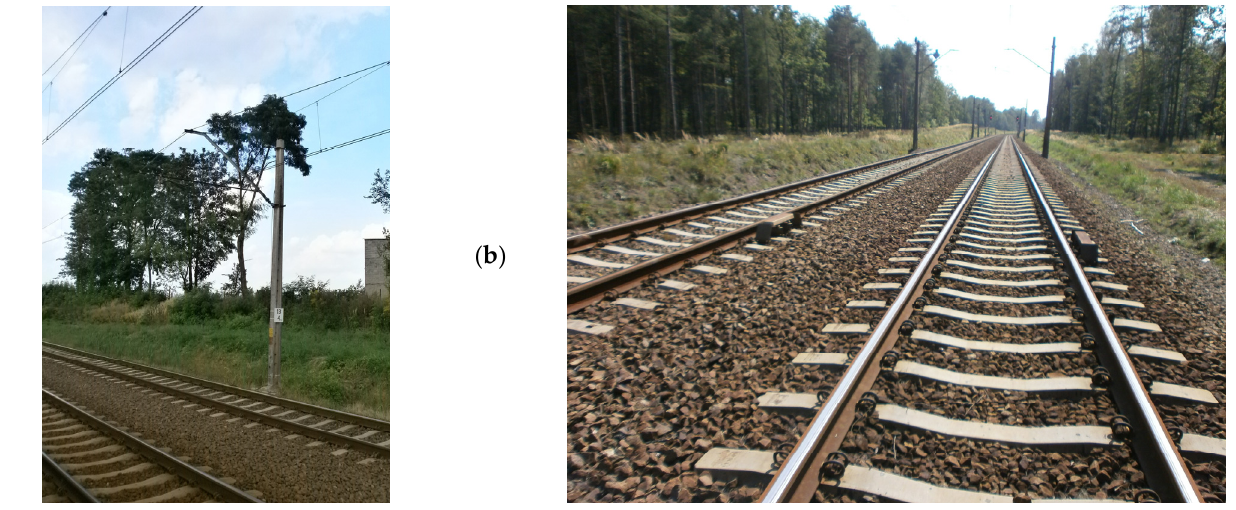
Figure 2. Railway infrastructure between ( a ) points 1 Lubliniec and 2 Rusinowice, and ( b ) points 3 Kosz ę cin and 4 Kalety. 3 Kosz˛ecin and 4 Kalety. Table 1. Technical exploitation specifications of the complete route. Technical Exploitation Parameters of Railway Lines